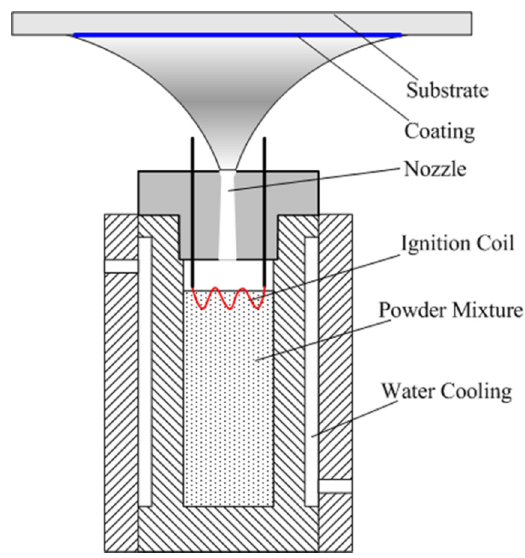
Figure 1. The device of fabricating theAl coating by thermal explosion spraying.